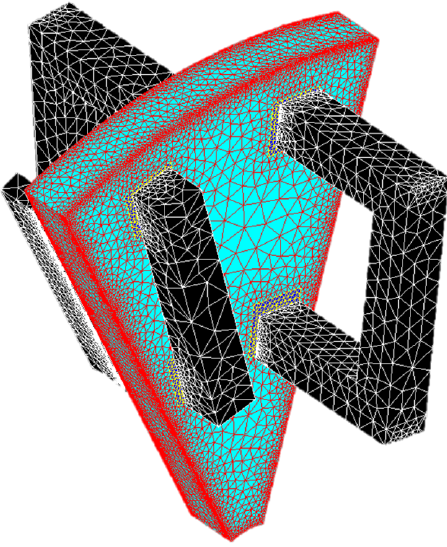
Figure 10. Meshed model of one pole pair.